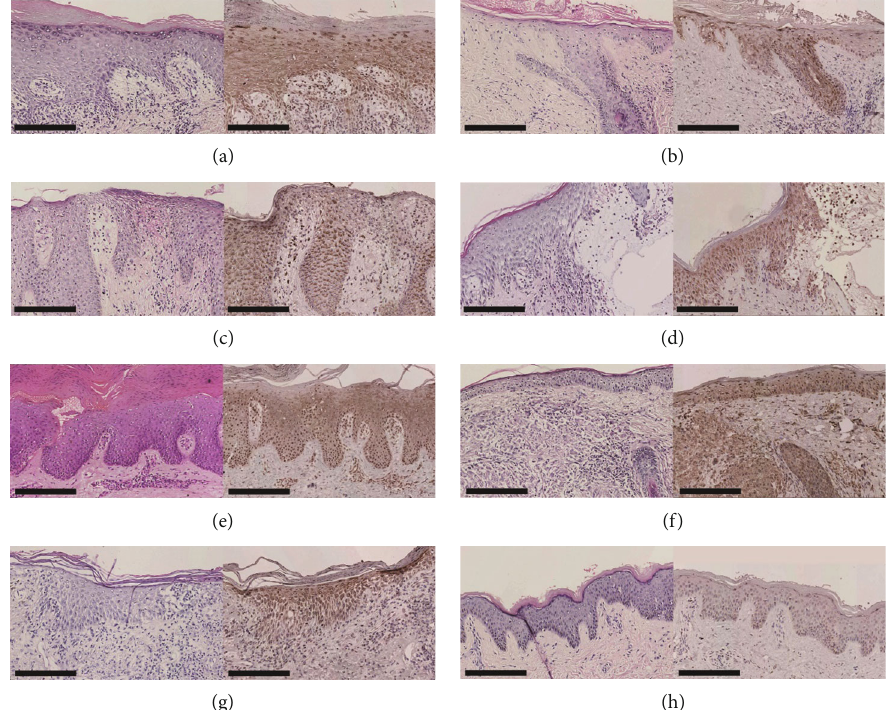
Figure 1: TSLP was expressed in the epidermis of all skin samples: (a) LP, (b) DLE, (c) eczema, (d) BP, (e) PsV, (f) sarcoidosis, (g) MF, and